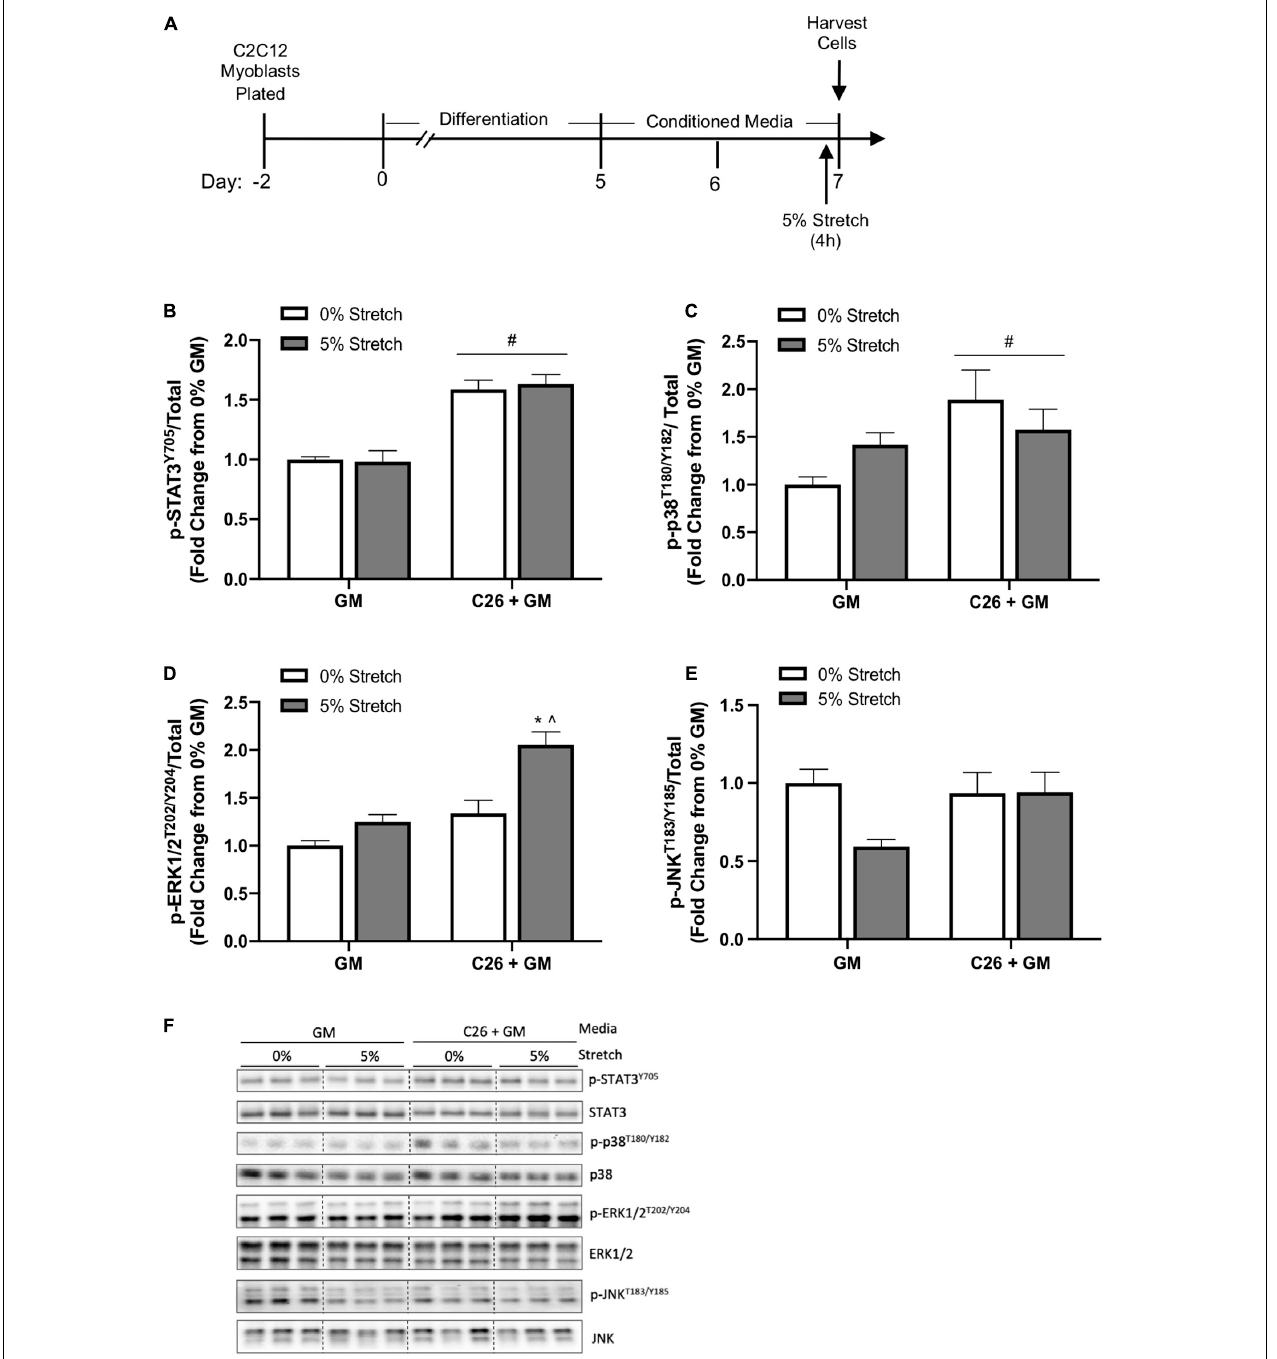
FIGURE 6 | Effects of 4-h stretch on colon-26 (C26) conditioned media-induced myotube signaling pathways. (A) Experiment overview: C2C12 myoblasts are plated on in growth media (GM); after 48 h at ∼ 85% confluence, differentiation media is added, which corresponds to day 0. At day 5 of differentiation, conditioned media (CM; GM or C26 + GM) is diluted with 50% serum-free DMEM and added to wells for 48 h. Myotubes are either left unstretched (0%) or stretched 5% in the last 4 h of CM incubation. Immediately after stretch, cells are harvested for protein. Western blotting analyses of the ratio of phosphorylated (p-) to total protein expression of (B) signal transducer and activator of transcription 3 (STAT3 Y 705 ) ( n = 9–12/group), (C) p38 T 180 / Y 182 MAPK ( n = 6/group), (D) extracellular signal-regulated kinase 1/2 (ERK1/2 T 202 / Y 204 ) ( n = 6/group), and (E) c-Jun N-terminal kinase (JNK T 183 / Y 185 ) ( n = 9/group) protein expression. (F) Representative Western blotting images; dashed line represents different areas of the same gel. Data are presented as means ± SEM as a fold change from GM 0% stretch. Two-way ANOVAs were performed to determine differences. # Main effect of C26 + GM; *significant from GM 0% stretch, ˆsignificant from C26 + GM 0% stretch. Statistical significance set at p ≤